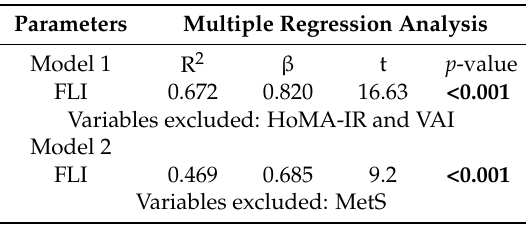
Table 5. Multiple regression analysis models (stepwise method) with the circulating levels of TMAO as dependent variable to estimate the predictive value of: (a) cardio-metabolic indices; (b) FLI and